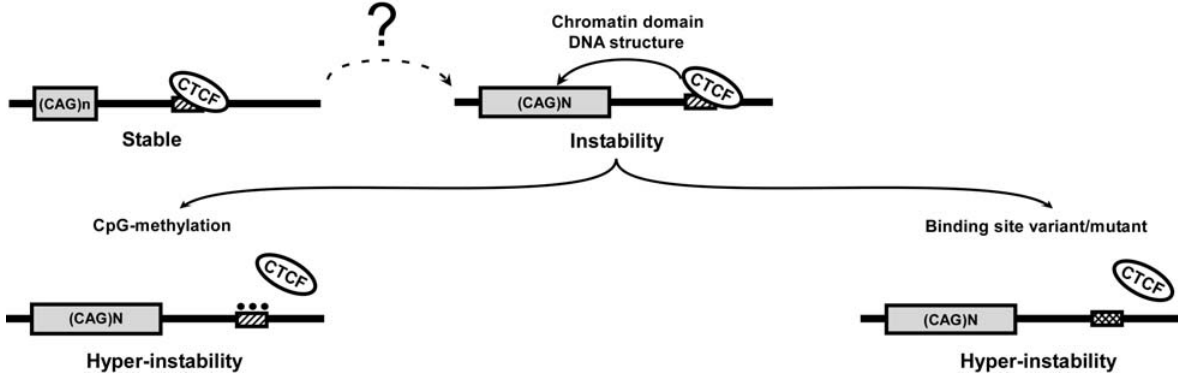
Figure 5. Model for CTCF regulation of CAG repeat instability. Non-expanded CAG repeat is stable, as CTCF is bound to adjacent site. Upon repeat expansion, chromatin environment and DNA structure of repeat region is altered, permitting instability. Loss of CTCF binding at adjacent CTCF binding site, either by CpG methylation or CTCF binding site mutation, further promotes repeat instability.